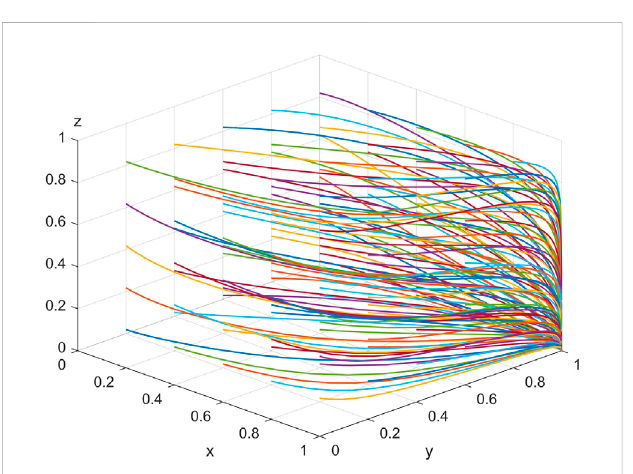
FIGURE 6 System evolution process in the rapid development stage.